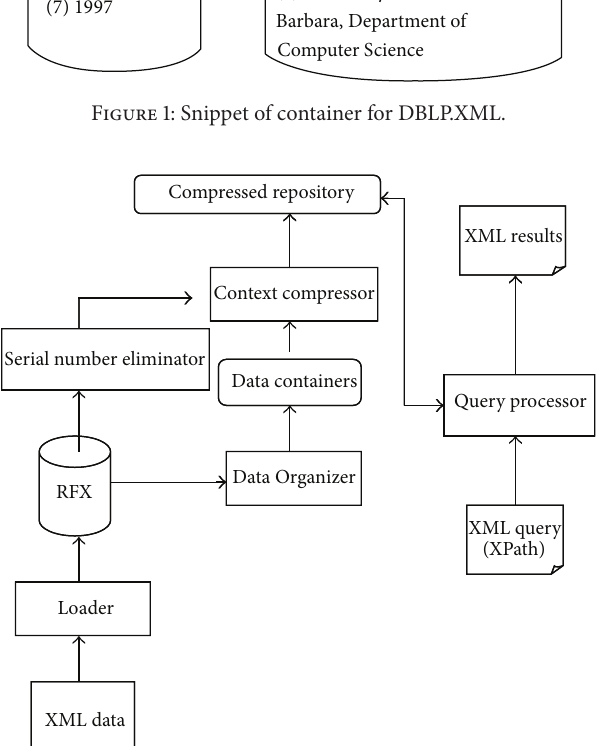
Figure 2: Architecture of QRFXFreeze.